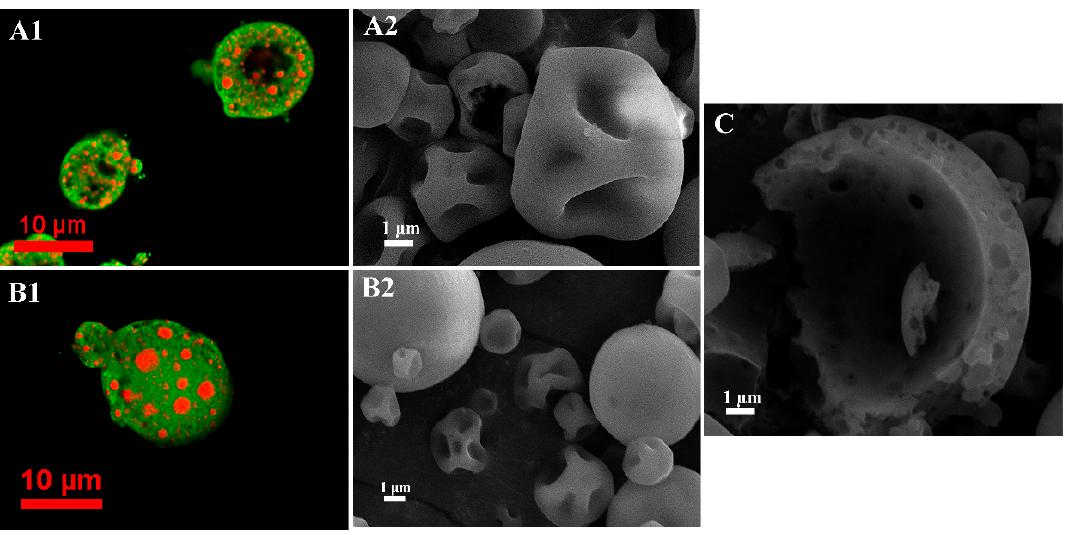
Figure 1. SEM (10,000 × ) and CLSM (100 × ) images of powdered microcapsules. (( A1 ) and ( A2 ) whey protein isolate (WPI) used as wall materials alone, ( B1 ) and ( B2 ) WPI and maltodextrin (MD) with dextrose equivalent (DE) values of 18 used as wall materials, ( C ) inside of powdered microcapsules).